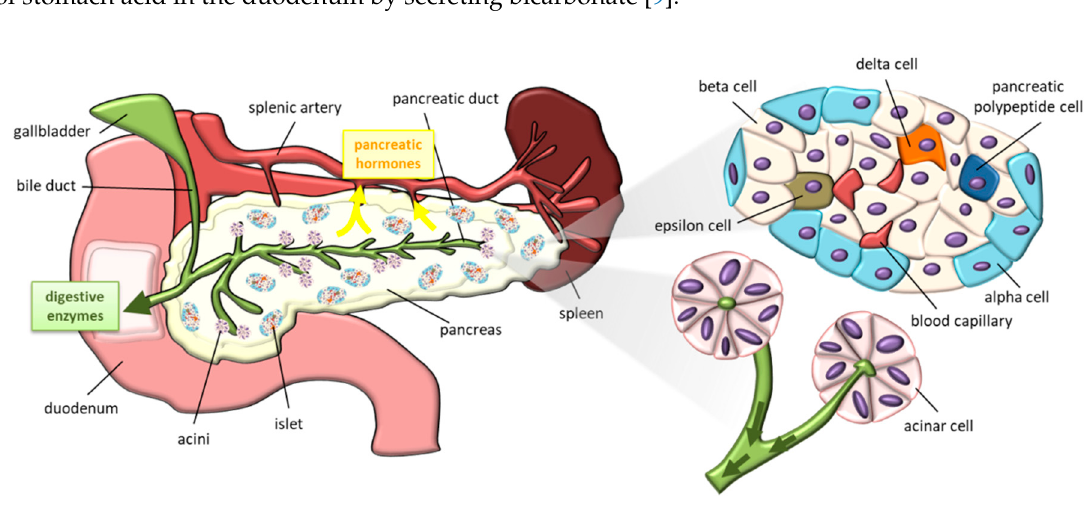
Figure 1. Schematic representation of pancreas (left side), pancreatic islet and acini (right side). Embedded within the exocrine tissue, endocrine cells are organized into islets containing